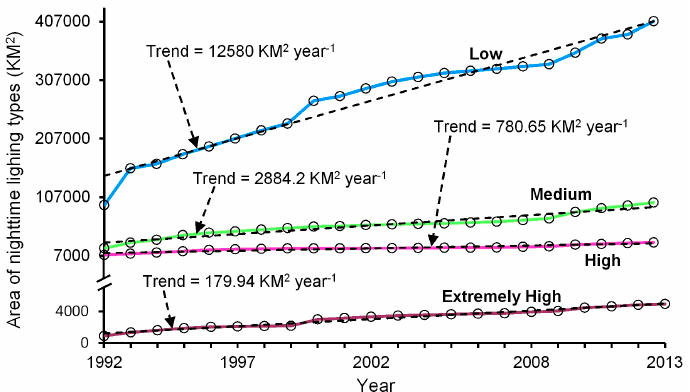
Figure 6. Changing trends in different types of nighttime lighting areas across Southeast Asia from 1992 to 2013.